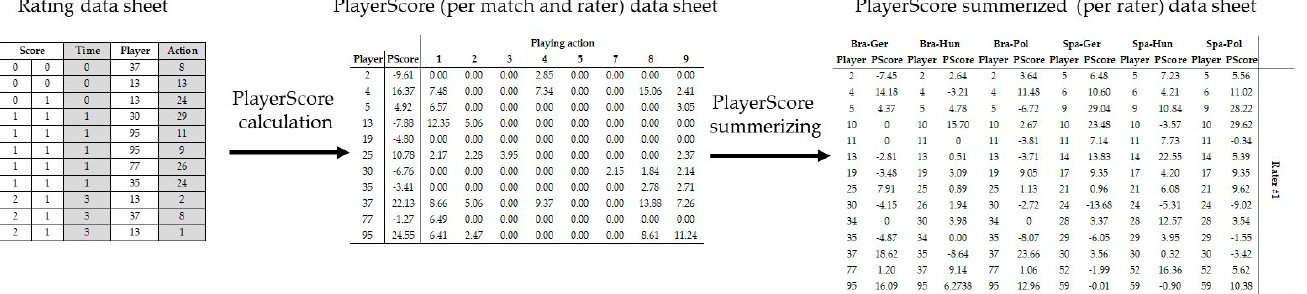
Figure 2. Outline of the methodology for the PlayerScore rating, calculation and summarizing pro- cess (PScore: PlayerScore; Bra-Ger: Brazil against Germany; Bra-Hun: Brazil against Hungary; Bra-Pol: Brazil against Poland; Spa-Ger: Spain against Germany; Spa-Hun: Spain against Hungary; Spa-Pol: Spain against Poland).